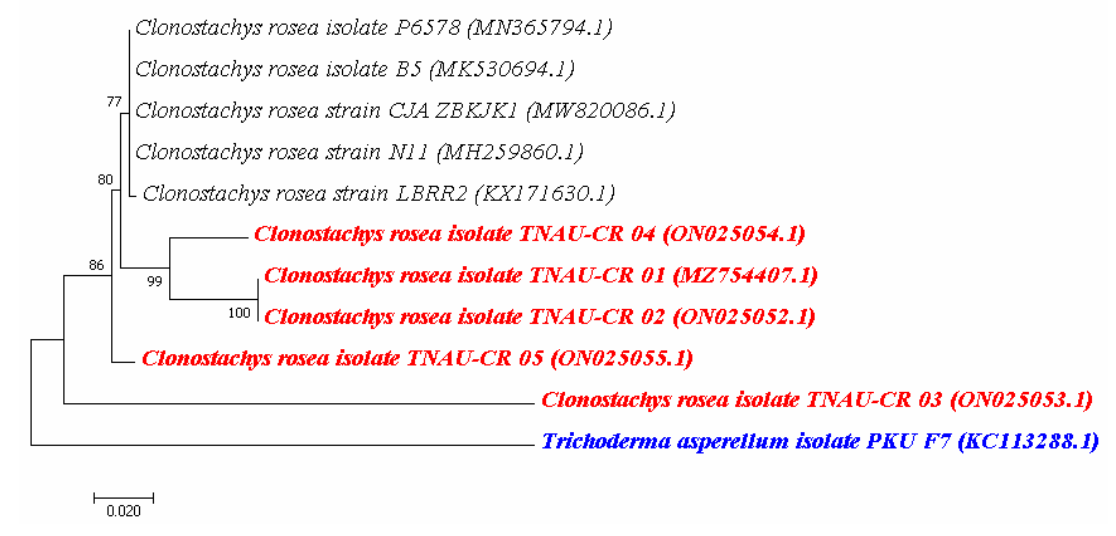
Figure 2. Phylogenetic analysis of C. rosea isolates. ( Red color —Indicates different C. rosea isolates; Blue color —Indicates out group).